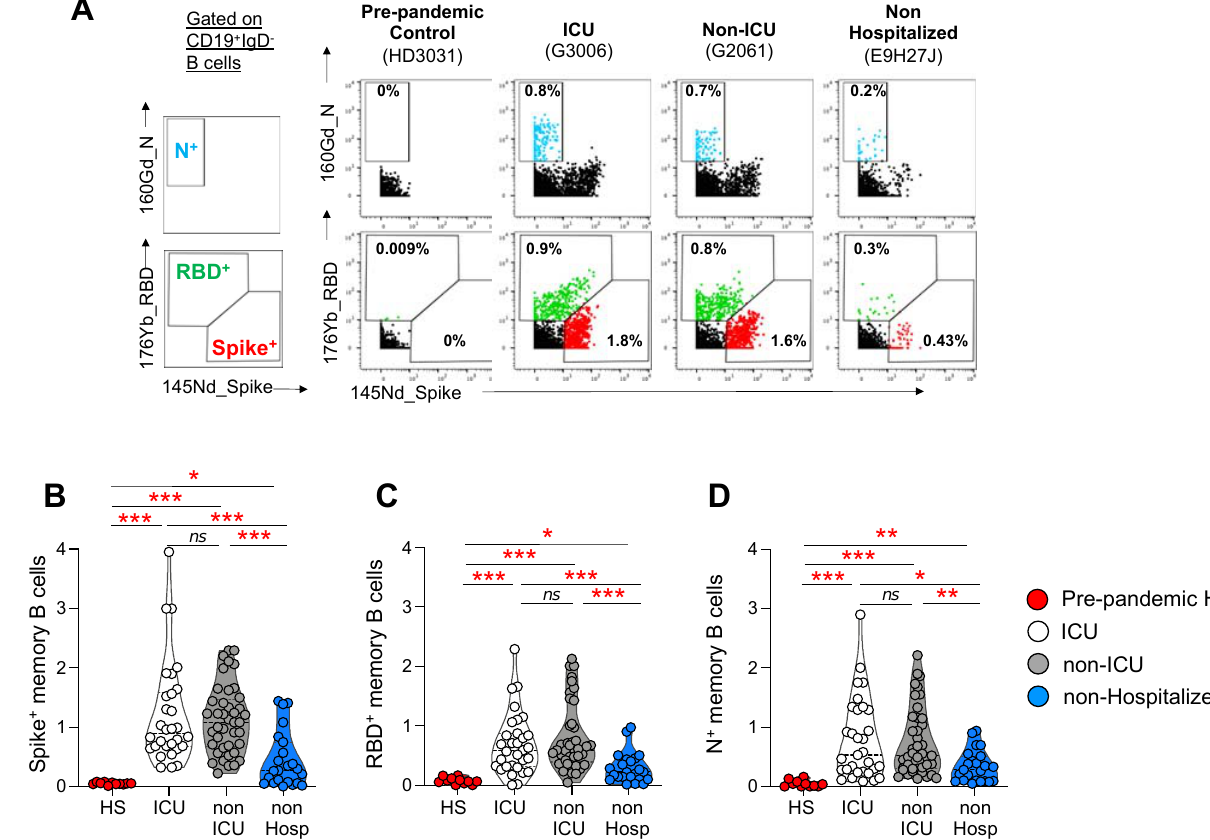
Figure 2. Frequencies of Spike, RBD, and N ‐ specific B cells in ICU, non ‐ ICU, and non ‐ hospitalized individuals. PBMCs from ICU (N = 31), non ‐ ICU (N = 41), and non ‐ hospitalized (N = 23) individuals at 6 months POS and from pre ‐ pandemic controls (N = 11) were stained with biotinylated Spike, RBD, and N proteins, which have been linked with streptavidin ‐ conjugated metals, and a panel of 38 B cell ‐ related markers. ( A ) Representative mass cytometry profiles of the total CD19+IgD − B cell populations binding to the Spike, RBD, and N probes in one representative pre ‐ pandemic control (HD3031), one ICU patient (G3006), one non ‐ ICU patient (G2061) and one non ‐ hospitalized (E9H27J) individual. ( B , C , D ) Cumulative data are shown on the frequencies of IgD ‐ CD19+ ‐ specific B cells in the three study groups. Statistical significance ( p ‐ values) was obtained using a one ‐ way ANOVA (Kruskal–Wallis test), followed by the Mann–Whitney test. Red stars indicate statistical significance (* = p < 0.05; ** = p < 0.01; *** = p < 0.001); ns = not significant. The cumulative data indicated that the frequencies of Spike (ICU = 1.2%; non ‐ ICU = 1.13%, non ‐ hospitalized = 0.44%), RBD (ICU = 0.69%; non ‐ ICU = 0.8%; non ‐ hospitalized =